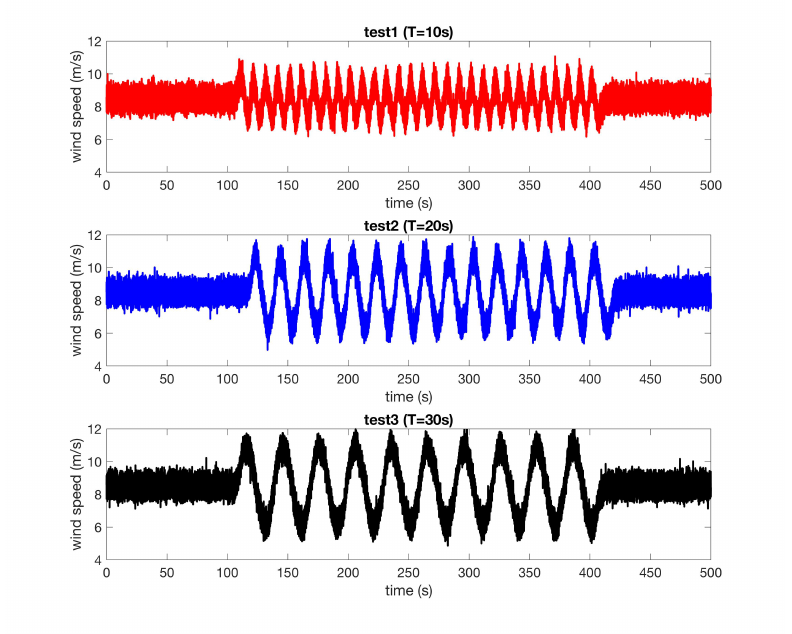
Figure 4. The wind time series for test 1, test 2, and test 3.